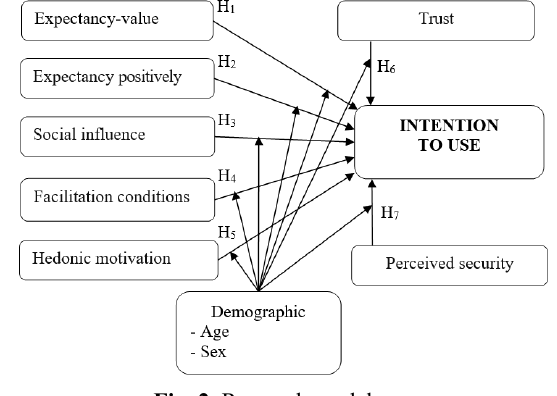
Fig. 2. Research model Source: Proposed Research